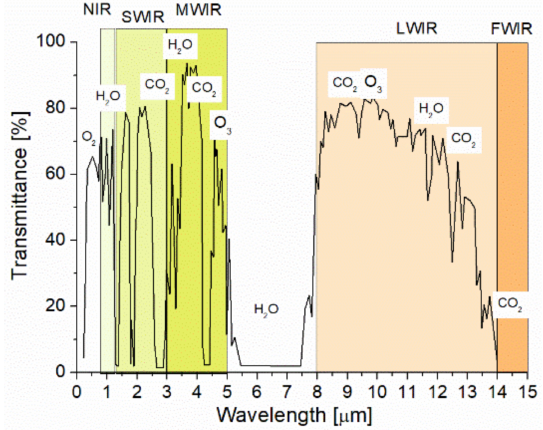
Figure 2. Spectral atmospheric